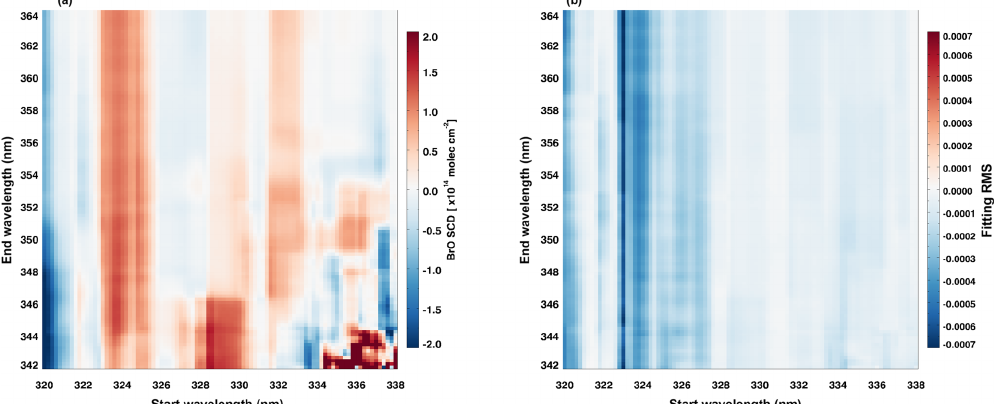
Figure A2. Color-coded means of differences for (a) BrO SCDs and (b) fitting rms values between analyses including the Taylor series approach (see Fig. A1) and the standard DOAS (see Fig. 2 in Sect.